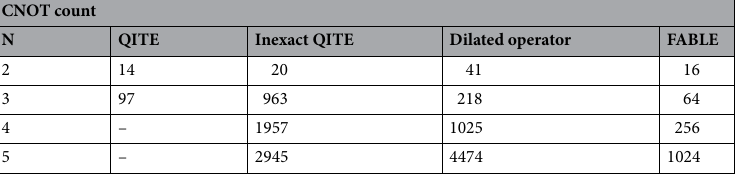
Table 1. CNOT gate count at various system sizes N for approximating the imaginary time evolution step of TPQ state preparation with the QITE, inexact QITE, dilated operator, and FABLE algorithms at β = 1 .